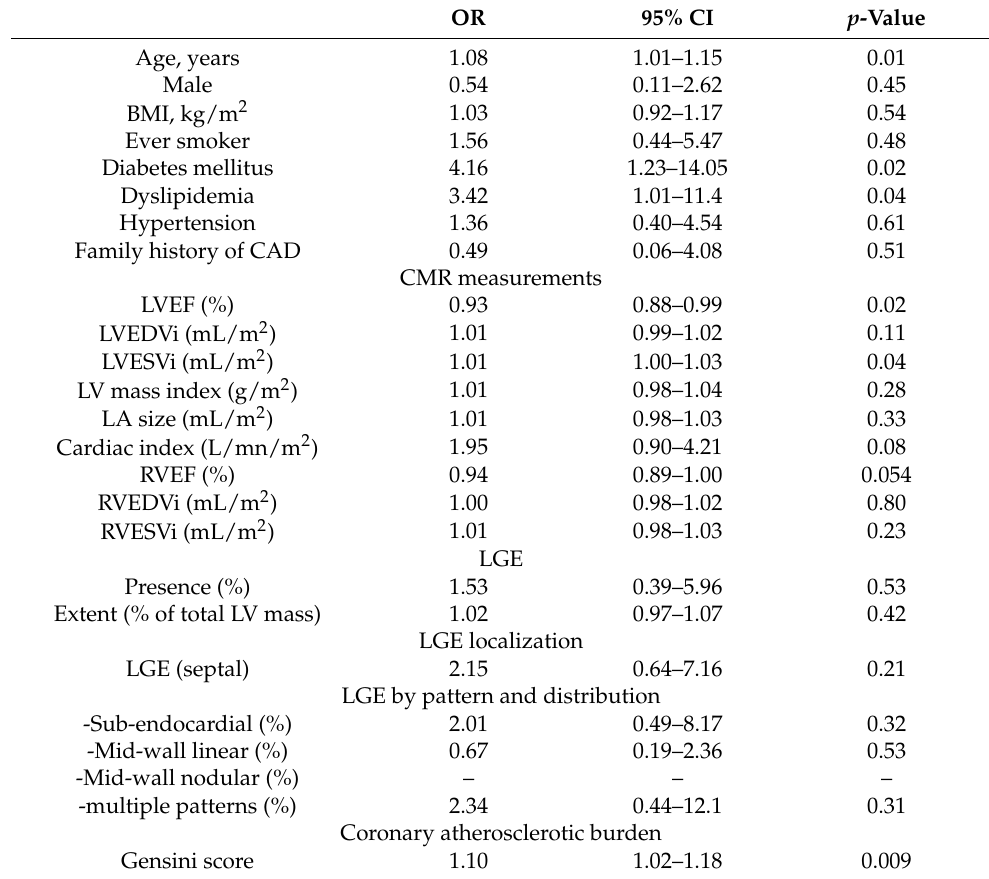
Table 2. Univariate logistic regression analysis for MACE.